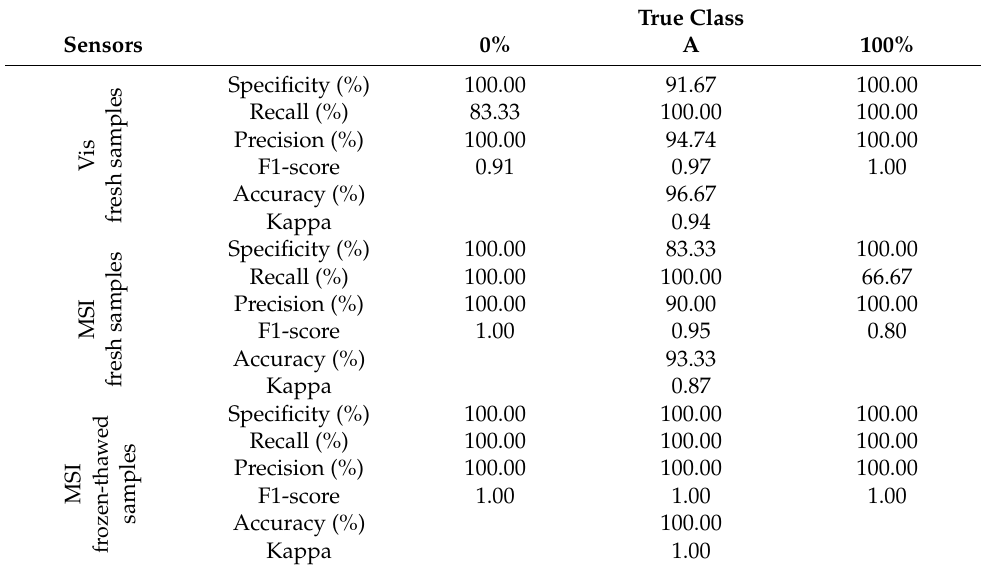
Table 4. Specificity, recall, precision, F1-score, accuracy and kappa for the classification of SVMs for the external validation ( n = 30) of fresh samples using Vis and MSI data and of frozen-thawed samples using MSI data considering three classes: 0% beef-100% offal (0%); adulterated (A); 100% beef-0% offal